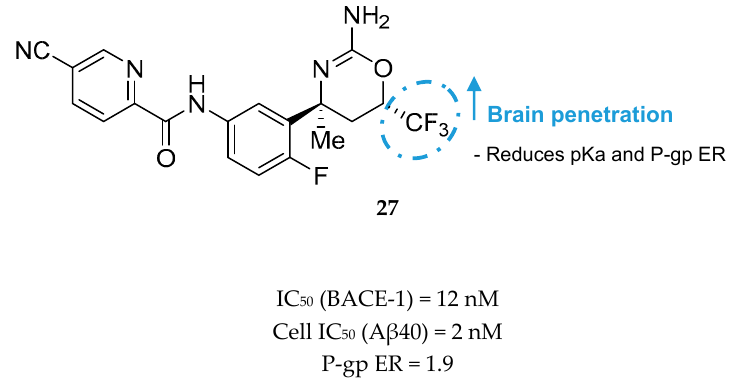
Figure 25. Oxazine-based compound 27 with a trifluoromethyl group developed by Roche.